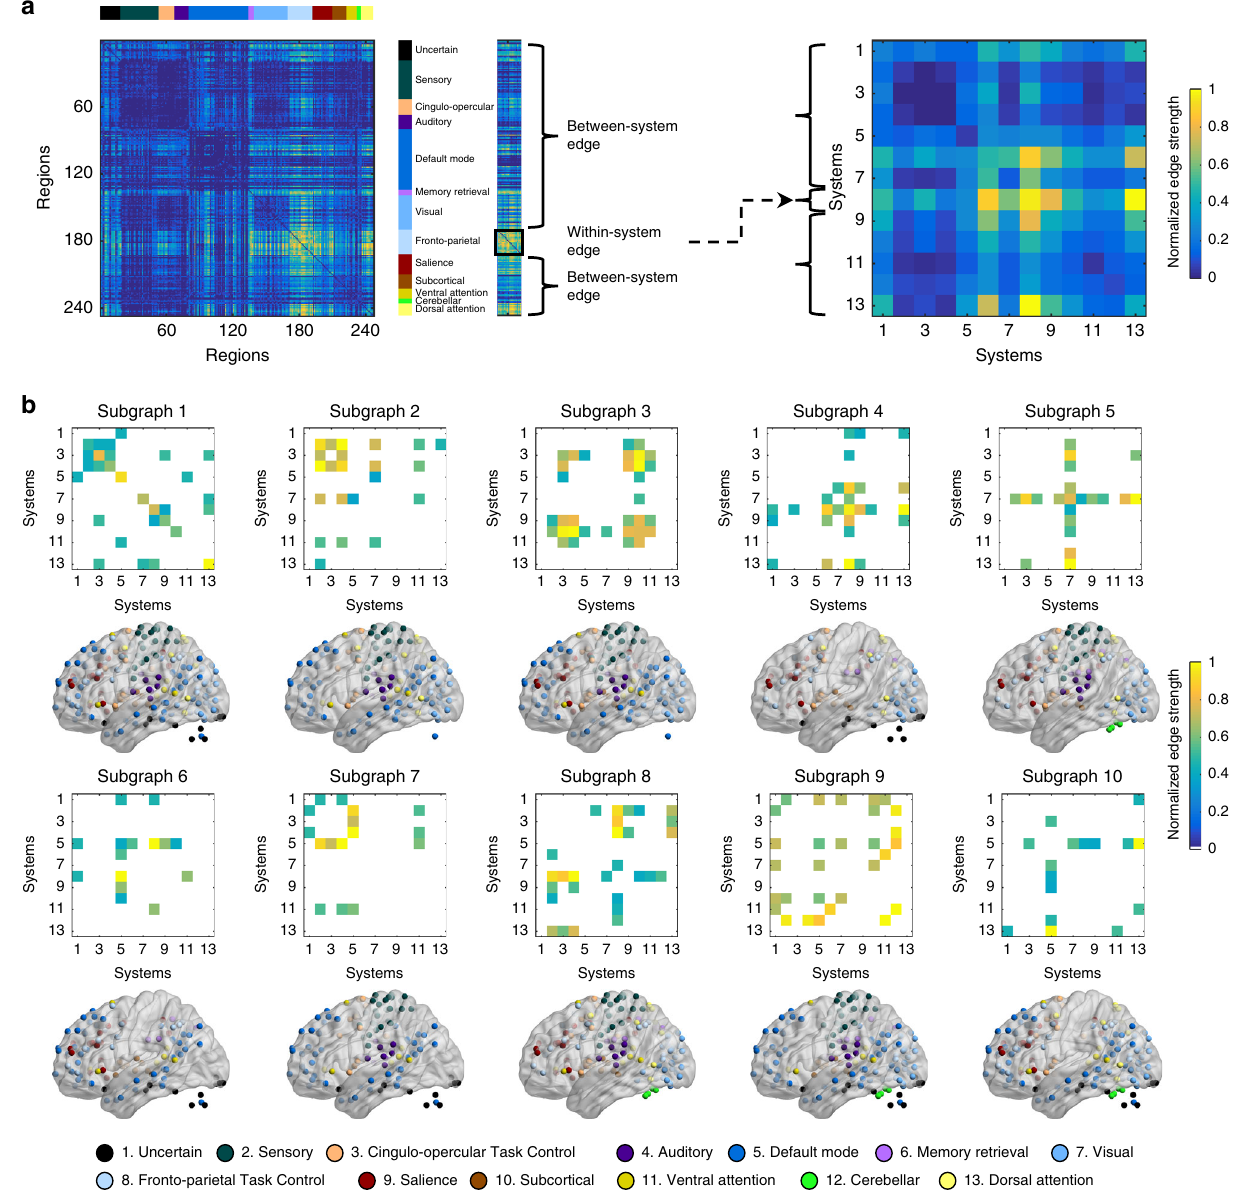
Fig. 3 Patterns of connectivity in subgraphs. a Converting edges between nodes into edges between systems. First, the edges of each subgraph can be folded into a square matrix, representing the edges between every pair of nodes (ROIs). Then, based on the 13 putative functional systems reported by Power et al. (2011), we categorized each edge according to the system(s) to which the two nodes (ROIs) belonged. We calculated the mean strength of edges linking a node in one system to a node in another system, and refer to that value as the between-system edge. Similarly, we calculated the mean strength of edges linking two nodes that both belong to the same system and refer to that value as the within-system edge. Edges between nodes and edges between systems were normalized into the scale between 0 and 1. b Edges between systems in the ten subgraphs identi fi ed by NMF. We show only signi fi cant edges ( p < 0.05 after the Bonferroni correction for multiple comparisons). For each subgraph, the top matrix shows the signi fi cant edges in that subgraph within or between systems. For example, Subgraph 1 has high edge strengths along the diagonal; thus, this subgraph describes functional connectivity that lies predominantly within functional systems. In contrast, subgraph 5 has high edge strengths along a single row and column, corresponding to the visual system; thus, this subgraph describes functional connectivity between the visual system and all other systems. Subgraphs varied in the degree to which they represent interactions within the same system (e.g., subgraph 1) versus interactions between different systems (e.g., subgraph 10). All nodes from systems involved in signi fi cant edges are shown on the brain below by the BrainNet Viewer 42 under the Creative